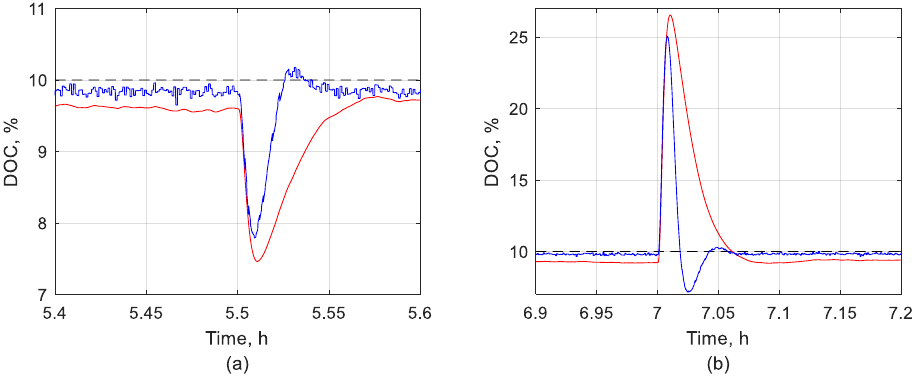
Figure 7. DOC disturbance compensation cases ( a ) and ( b ): PI controller with fixed parameters (red), adaptive PI controller with Gain Scheduling (blue), DOC set-point (black).